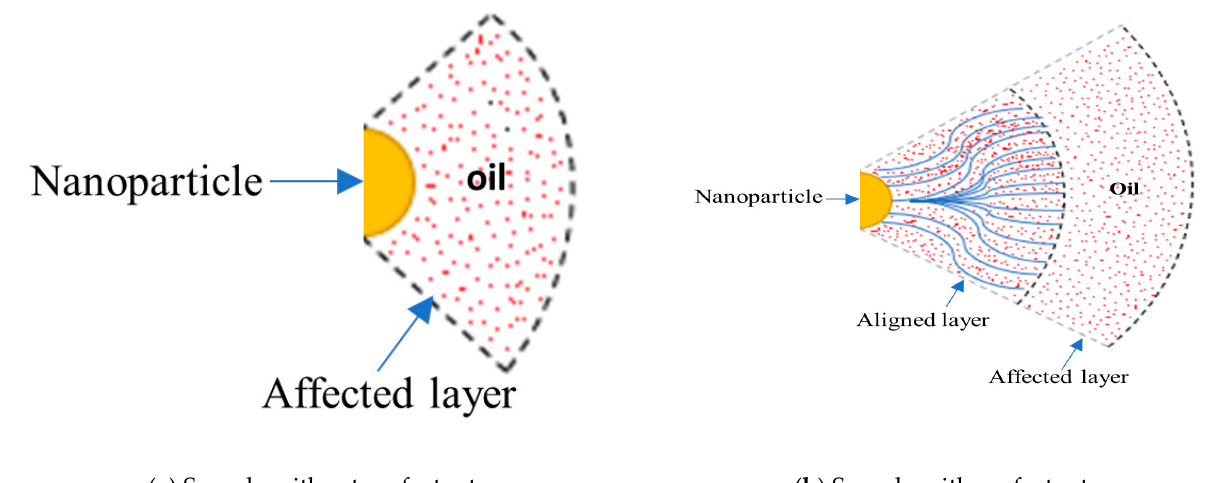
Figure 8. Interfacial zone structure in oil-based nanofluid.